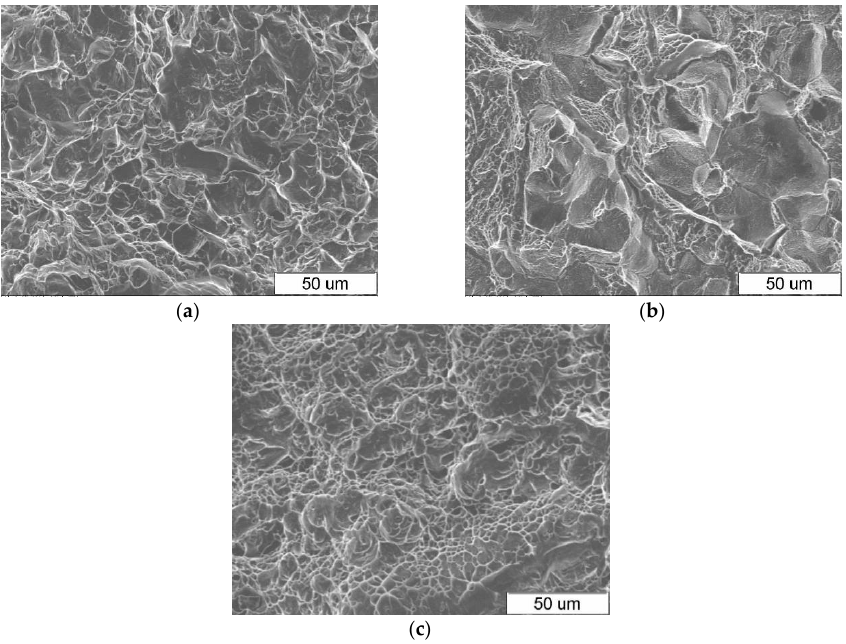
Figure 8. The typical fracture surface of ( a ) Ti64; ( b ) WZ and ( c ) Ti17.